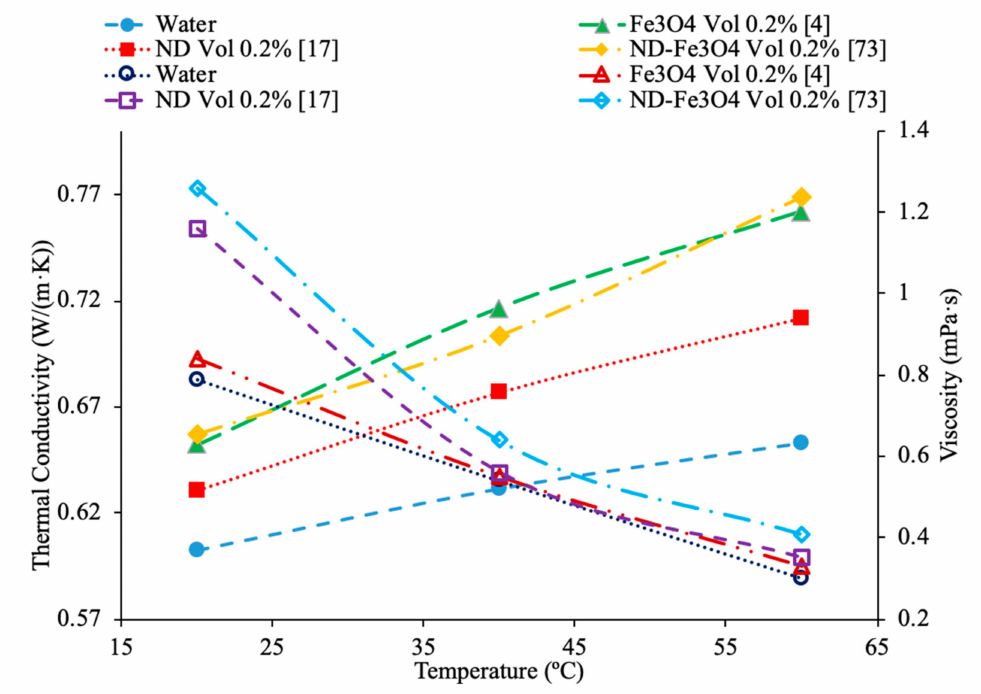
Figure 33. Thermal conductivity (increasing with temperature) and viscosity (decreasing with temper- ature) for ND–Fe 3 O 4 , ND, Fe 3 O 4 water-based nanofluids at a volume concentration of 0.2%